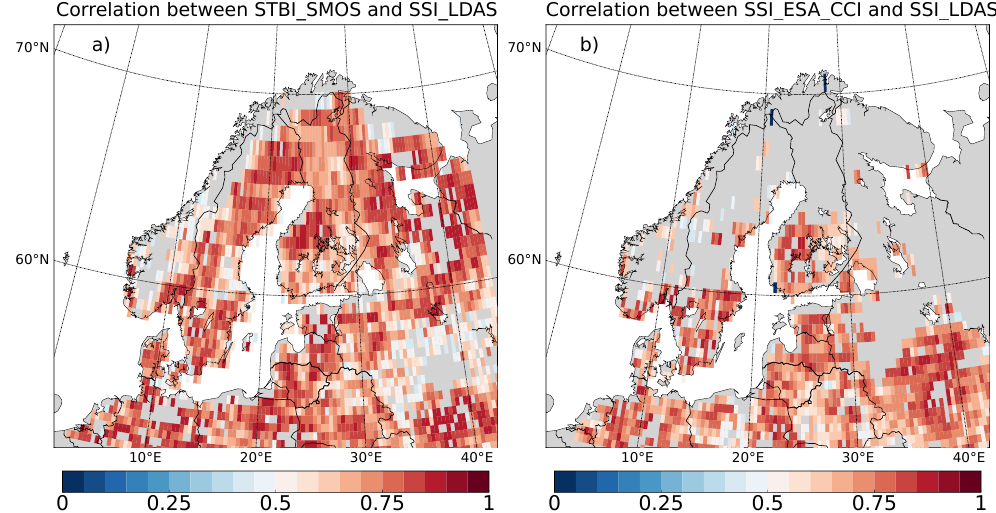
Figure 3. ( a ) Pearson correlation coefficient between the STBI_SMOS and SSI_LDAS, red regions indicate a high positive correlation, masked (grey) regions have a correlation not significantly different from zero. ( b ) Same as a) but for the Pearson correlation between the SSI_ESA_CCI and SSI_LDAS